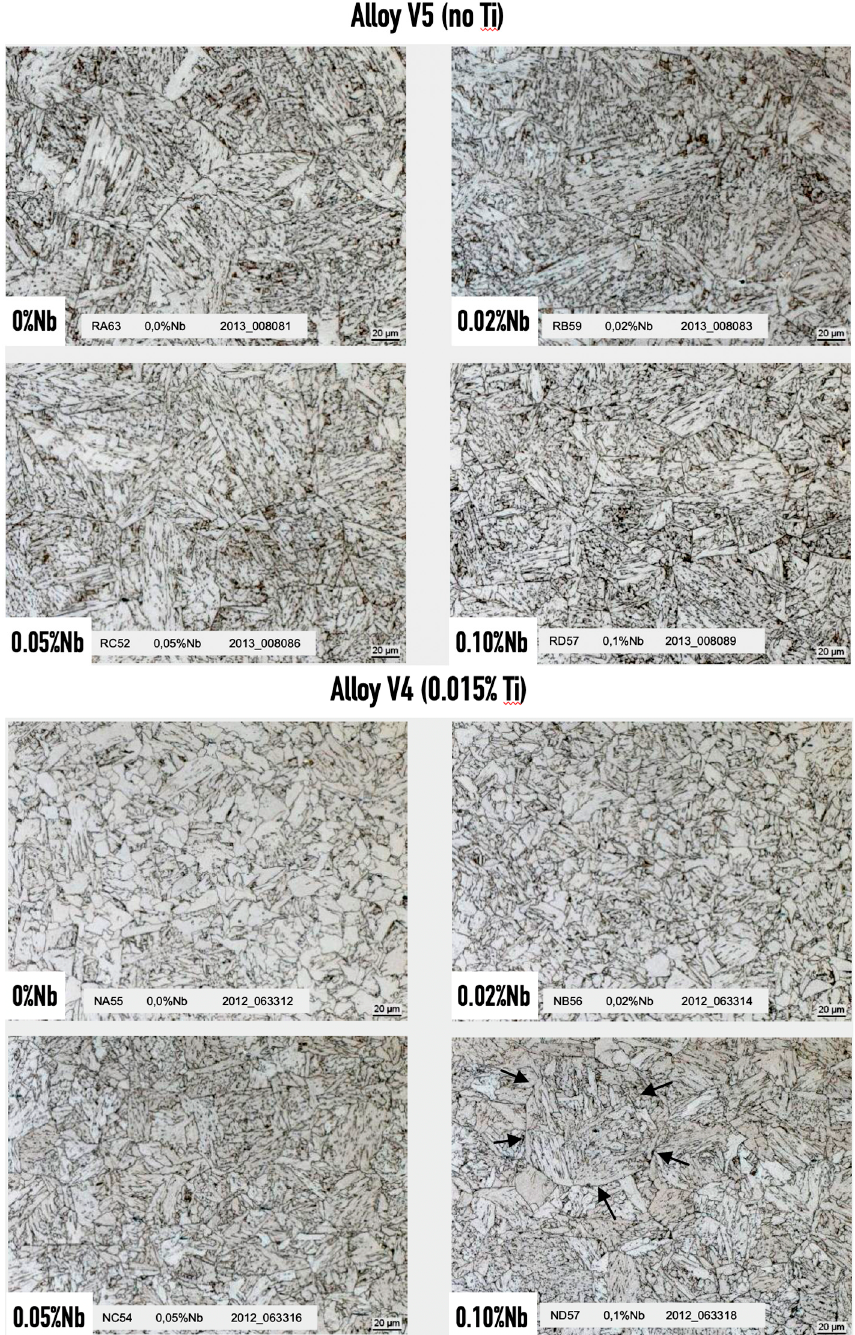
Figure 8. Effect of Ti and Nb micro-alloy addition on the microstructure in the CGZ (etching with Le Pera agent); abnormal prior austenite grain size in alloy V4-d (0.10%Nb) indicated by